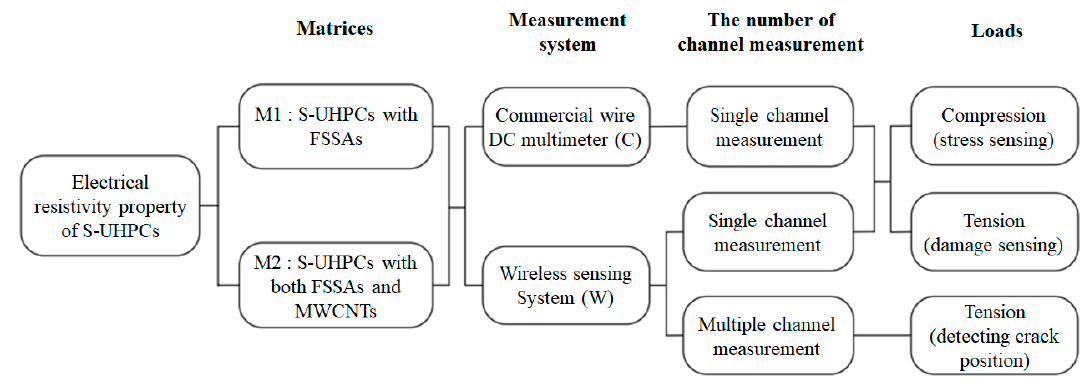
Figure 8. Experimental program.